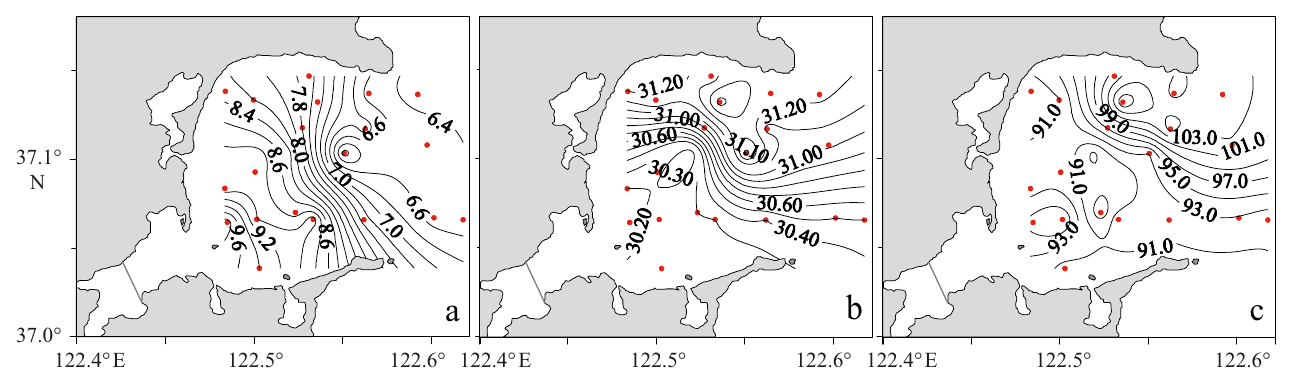
Fig. 2. Horizontal distributions of (a) temperature (°C), (b) salinity, and (c) the degree of dissolved oxygen (DO) saturation (%) in near-bottom seawater of Sanggou Bay (see Fig. 1 for station locations, red